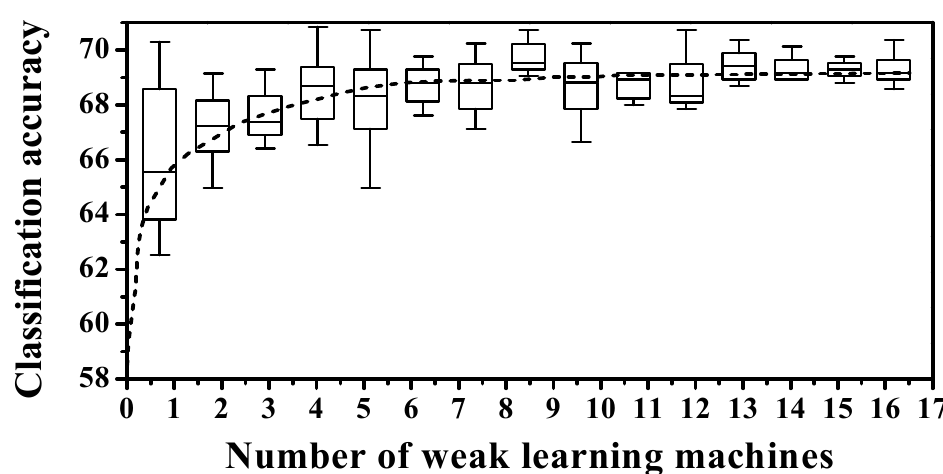
Figure 7. E ff ects of di ff erent numbers of weak learning machines on the classification accuracy of the Figure 7. Effects of different numbers of weak learning machines on the classification accuracy of the AdaBoost-BP AdaBoost-BP algorithm.